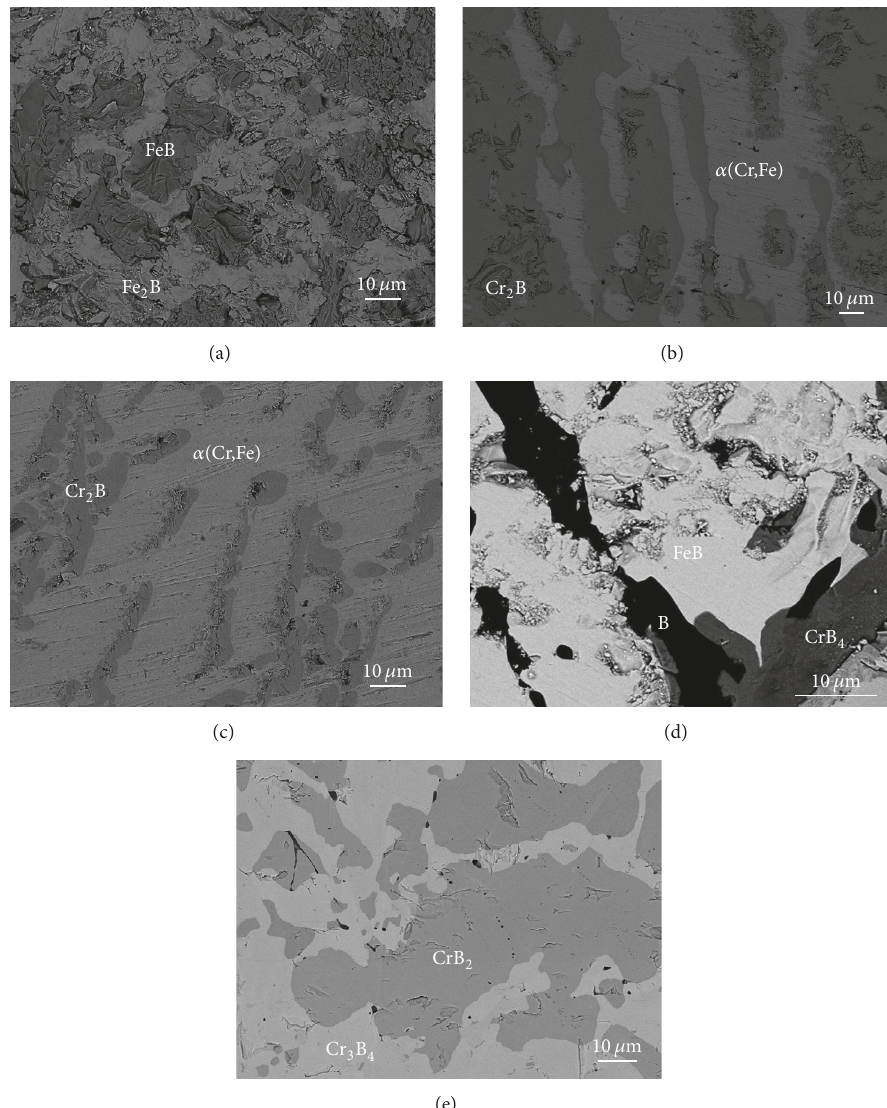
Figure 1: Microstructure of investigated B-Cr-Fe alloys after annealing at 1353 K for 1848 h: 50Fe-40B-10Cr (a); 15Fe-25B-60Cr (b); 8Fe-10B- 82Cr (c); 33Fe-62B-5Cr (d); 8Fe-62B-30Cr